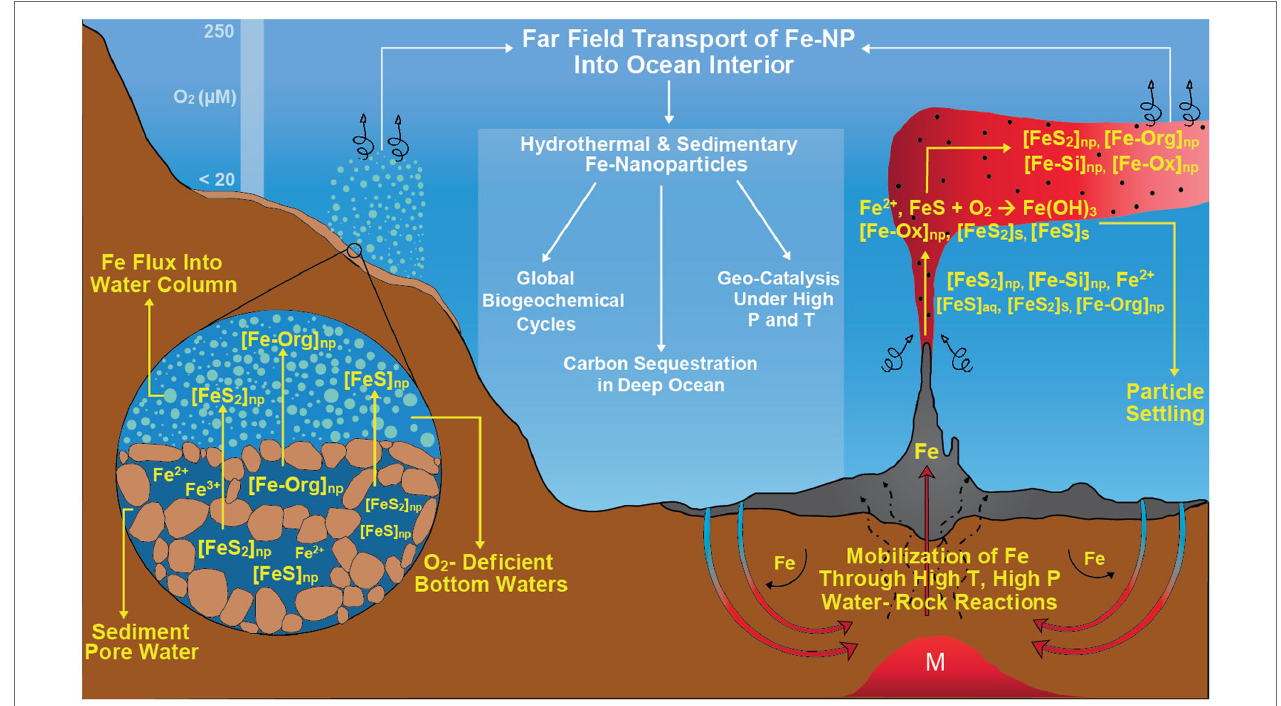
FIGURE 7 | Nanoparticles as an important geochemical actor across naturally occurring marine redox gradients such as high-temperature hydrothermal vents and reducing sediments where metal turnover is orders of magnitude higher compared to other ocean zones. These nanoparticle fluxes might have a primary role in global biogeochemical cycles, carbon sequestration in deep ocean and geo-catalysis under high pressure and temperature